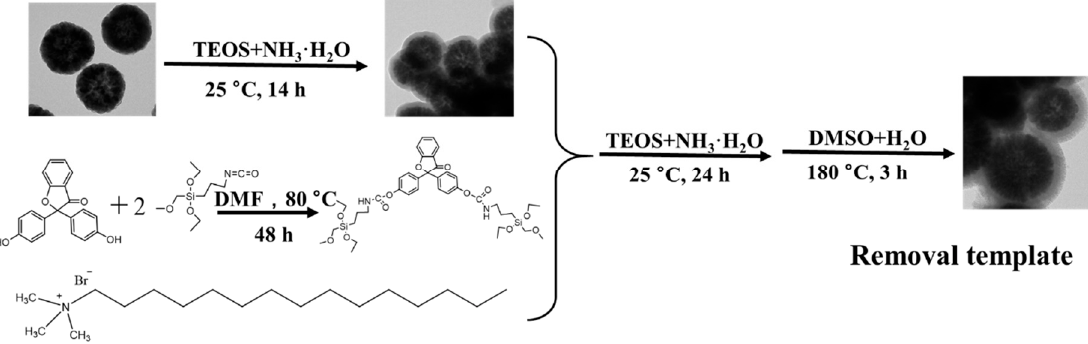
Figure 1. Schematic procedure of preparation of m-DMI-MSNPs.